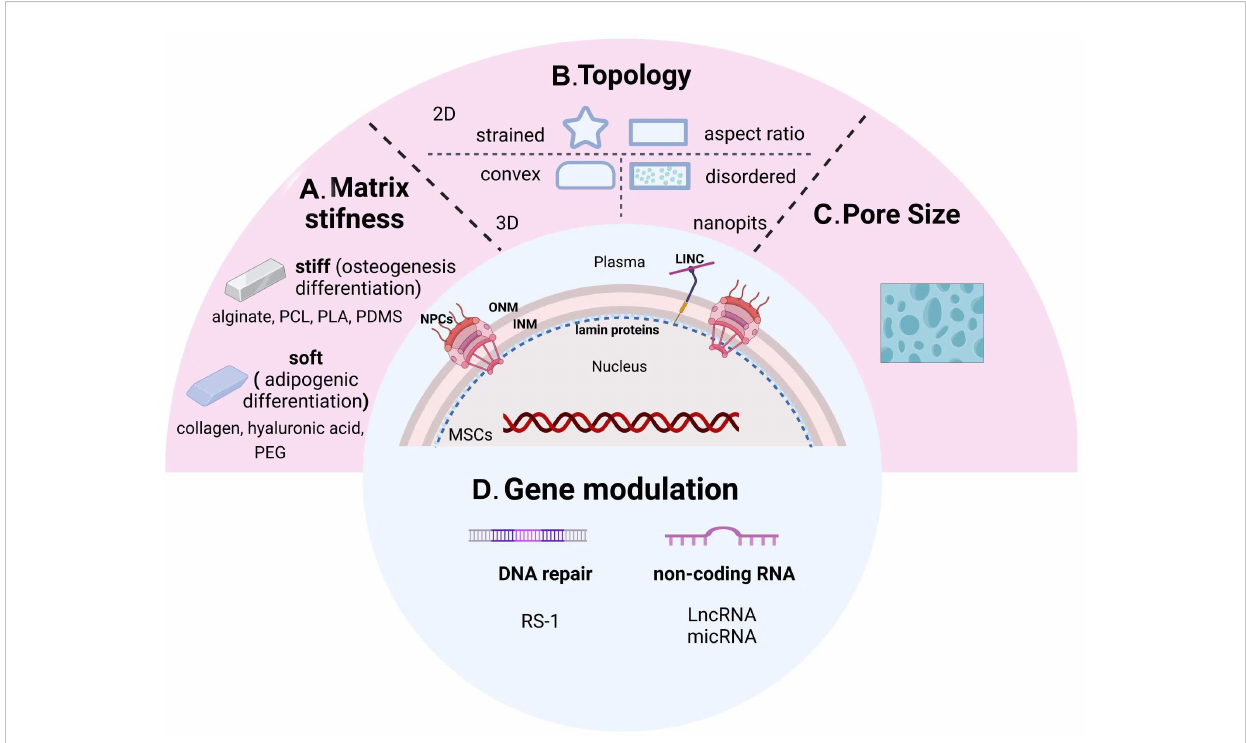
FIGURE 3 From sensing microenvironmental signals to gene modulation of nuclear-targeted guidelines. Physicochemical cues including matrix stiffness (A) , topology (B) , pore size (C) , and nuclear gene modi fi cations (D) manipulate the osteogenic differentiation tendency of MSCs. PCL, polycaprolactone; PLA, polylactic acid; PDMS, polydimethylsiloxane; PEG, poly (ethylene glycol); INM, inner nuclear membrane; ONM, outer nuclear membrane; NPCs, nuclear pore